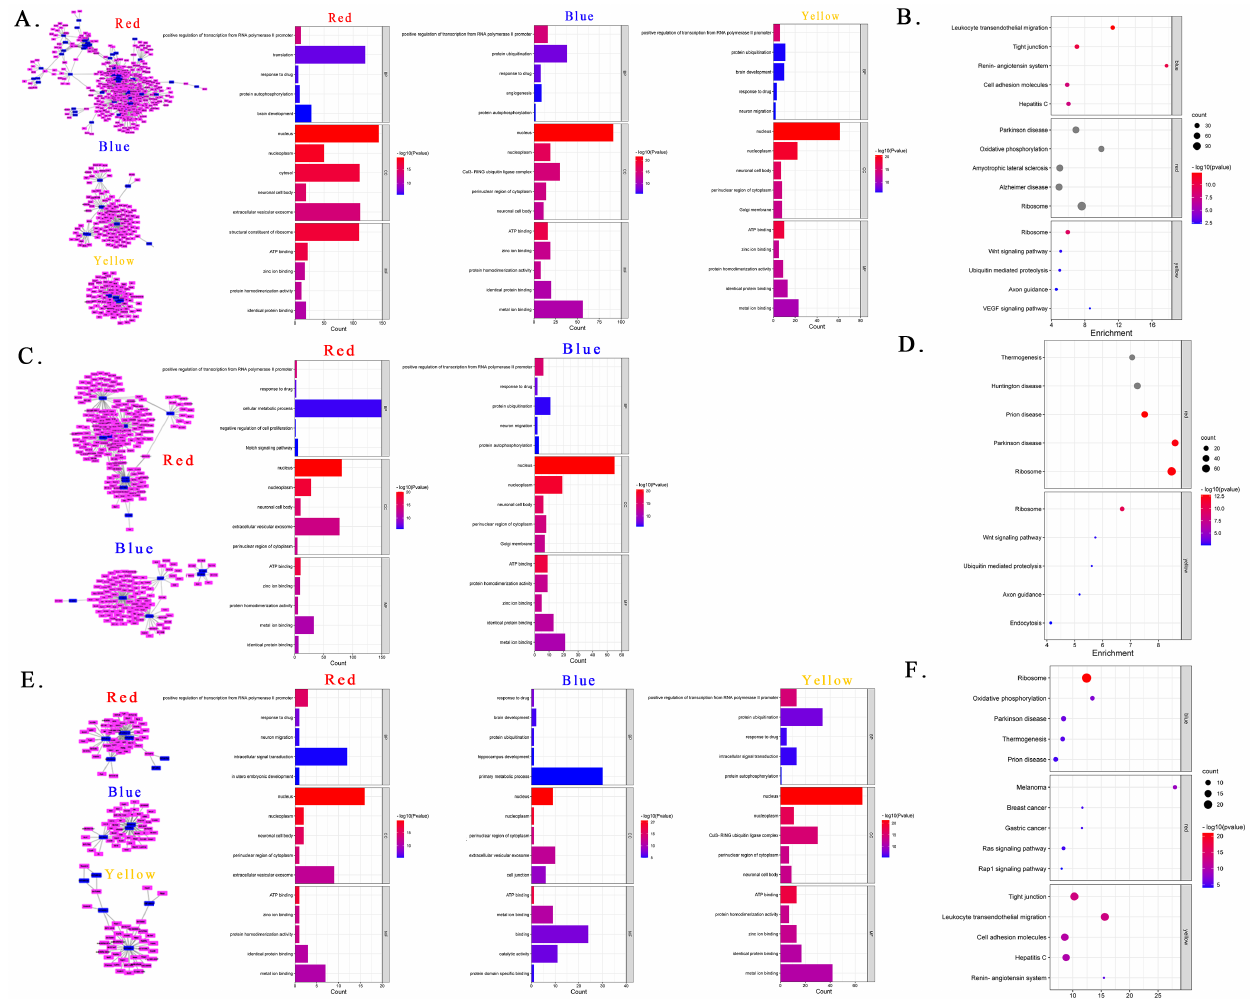
Figure 4. Gene Ontology (GO) and Kyoto Encyclopedia of Genes and Genomes (KEGG) enrichment analyses based on lncRNA–target gene co-expression clusters in fructose groups. ( A , B ) Enrichment analysis of three clusters in F13% using the cis method. ( C , D ) Enrichment analysis of two clusters in F13% using the trans method. ( E , F ) Enrichment analysis of three clusters in F40% using the cis method. Note: In the GO enrichment analysis results, the ordinate represents the name of GO terms; the abscissa represents the gene count; and the color represents the − log10 ( p -value) of GO terms. In the KEGG pathway enrichment analysis, each circle represents a KEGG pathway; the ordinate represents the pathway name; the abscissa represents the enrichment factor; the circle color indicates the p -value; and the circle size indicates the number of enriched genes in the